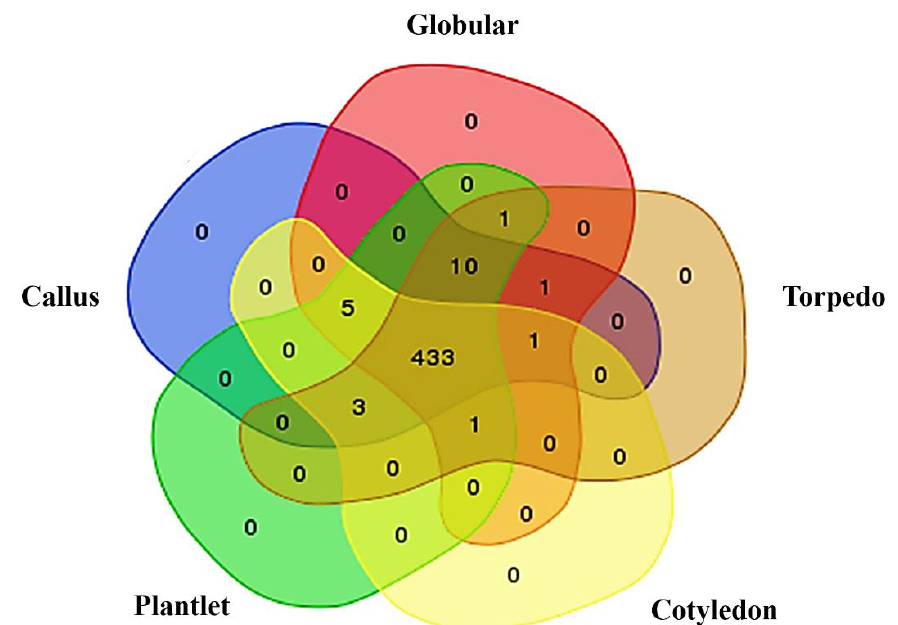
Figure 2. Overlap of identified phosphoproteins in callus (blue), globular (pink), torpedo (brown), cotyledon (yellow) and plantlet (green) stages.